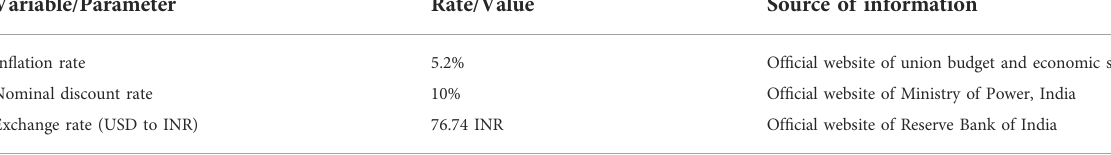
TABLE A2 Economic variables and other parameters (Ali et al.,